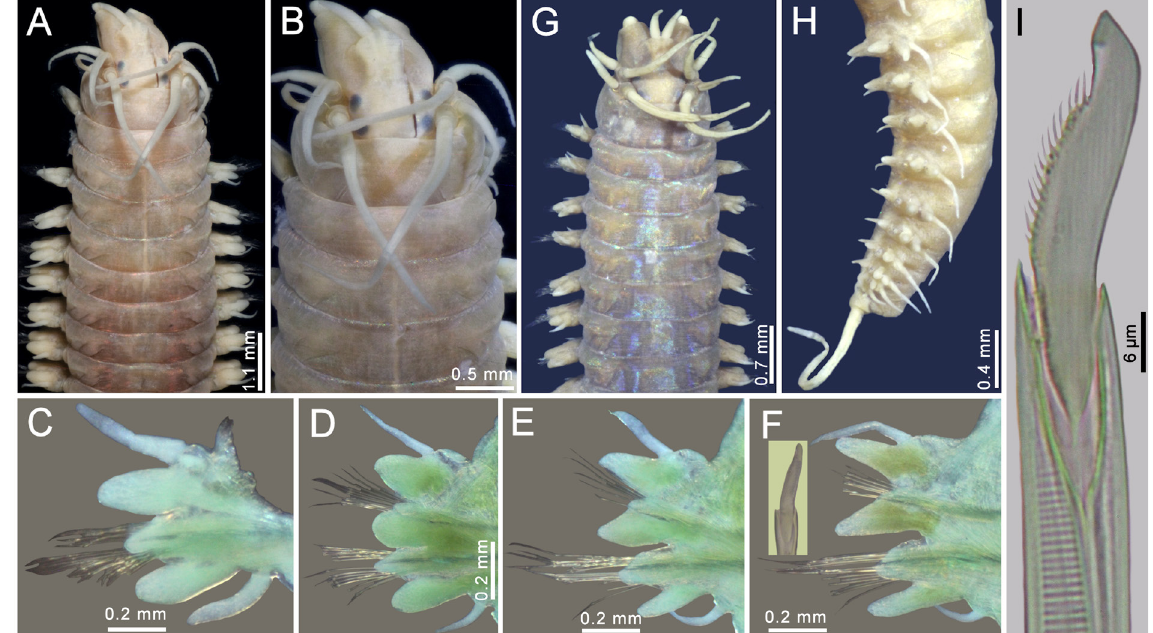
Fig. 6. Nereis splendida Grube, 1840, non-type, atokous specimens. A–F . MNHN 423-531. A . Anterior region, dorsal view. B . Anterior end, dorsal view. C . Chaetiger 2, right parapodium, anterior view. D . Chaetiger 15, right parapodium, anterior view. E . Chaetiger 30, right parapodium, anterior view. F . Chaetiger 55, right parapodium, anterior view (inset: homogomph falciger tip). G–H . MNHN 495-1. G . Anterior region, dorsal view. H . Posterior region, left lateral view. I . Another specimen (MNHN 423- 531), chaetiger 30, right parapodium, homogomph falciger